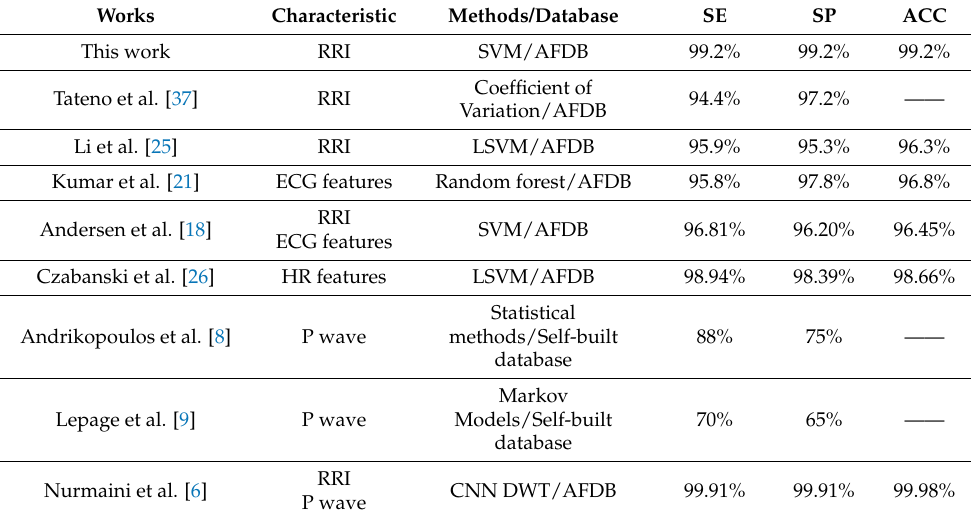
Table 11. Performance comparison of atrial fibrillation classification